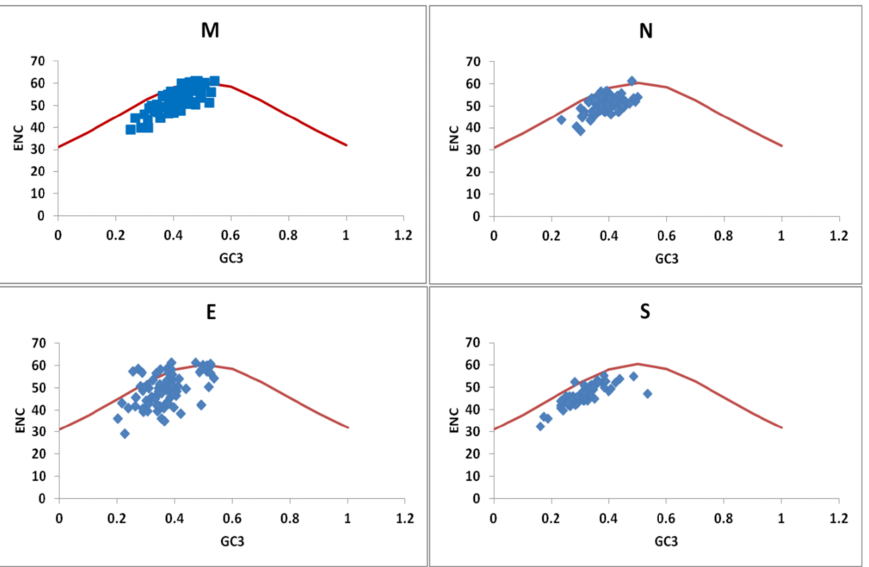
Figure 2. ENc plot for the different structural genes of the Coronaviridae family: ENc values for the different genes are plotted against the GC3 values. The expected ENC vs. GC3 plot is depicted as the red-colored curve, whereas the observed ENC vs. GC3 values for the particular virus are plotted as the blue color points. The values for the Enc were derived using the CodonW v. 1.4.2 software.